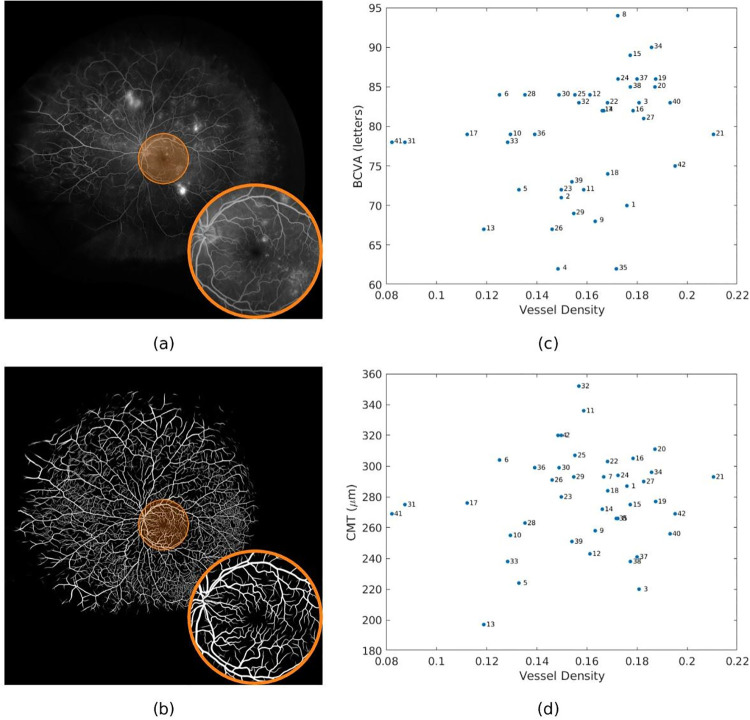
Vessel density within circular posterior pole region of radius 315 pixels (approximate diameter of 11.05 mm) correlates with best corrected visual acuity (BCVA), but not central retinal thickness (CRT).A. Example of ultra-widefield fluorescein angiography (UWFFA) image with the circular posterior pole region of radius 315 pixels (approximate diameter 11.05 mm) highlighted as an orange circle. B. Example of detected vessel map for the circular region. C. Scatter plots of vessel density vs. BCVA for the 42 patients in the study demonstrating a significant positive correlation between vessel density and BCVA (r = 0.4071, p = 0.0075). D. Scatter plots of vessel density vs. CRT for the 42 patients in the study, demonstrating absence of significant correlation between vessel density and CRT (r = 0.0533, p = 0.7376).